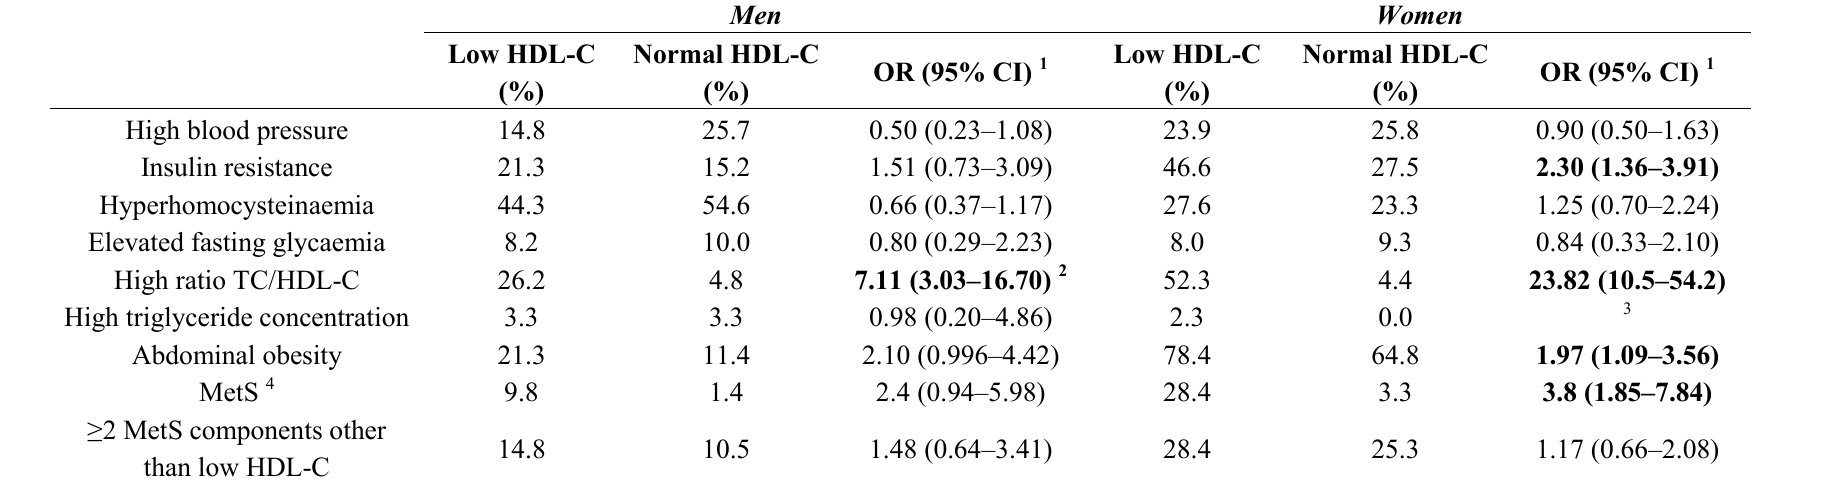
Table 6. Prevalence and odds of cardio-metabolic risk factors in low HDL-C